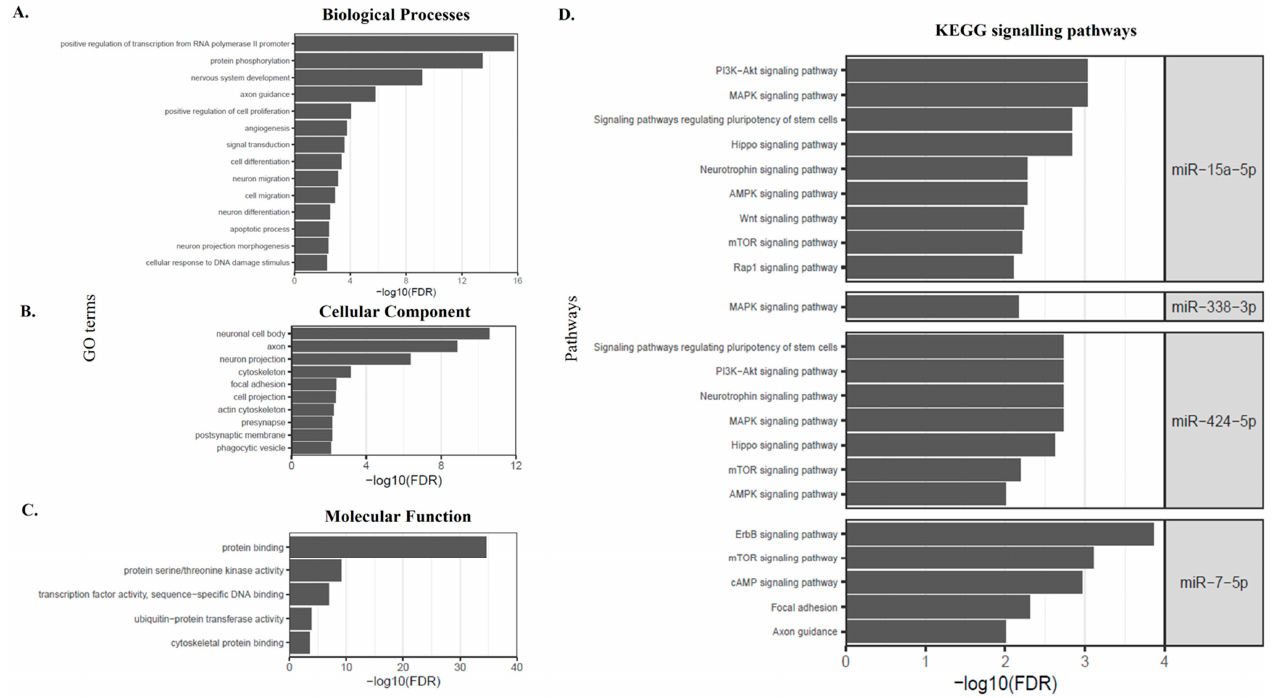
Figure 3. Gene ontology (GO) analysis of the target genes from the 14 candidate miRNAs to elucidate their key roles in ( A ) Biological Processes, ( B ) Cellular Components ( C ) Molecular Function and ( D ) KEGG pathway enrichment analysis of target genes from the 14 candidate miRNAs .